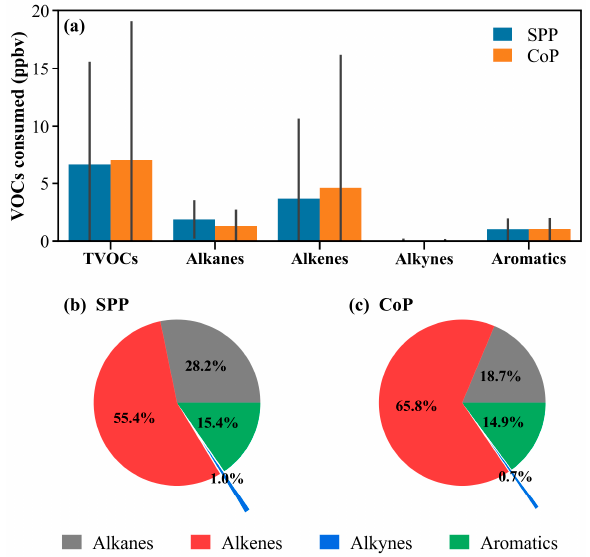
Figure 8. Concentration ( a ) and composition ( b , c ) of consumed VOCs in different pollution episodes. The error line on each bar corresponds to the standard deviation.